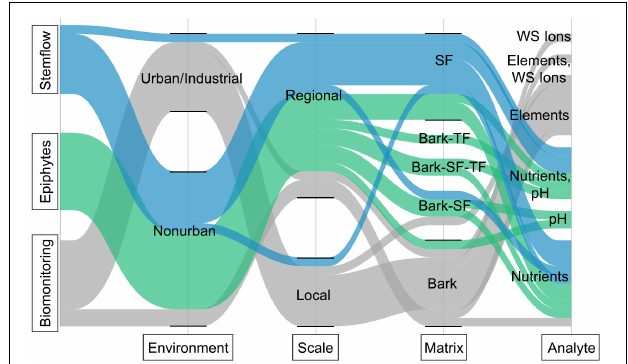
FIGURE 1 | Parallel plot illustrating approaches to the study of bark in three research areas: bark and biomonitoring ( n = 10 studies), bark and stemflow ( n = 8 studies), and bark and epiphytes ( n = 9 studies). The y -axis depicts the three research areas. The width of the parallel lines represents the frequency of studies falling in each category along the x -axis. The x -axis categories include the environment in which the study was conducted (urban/industrial or nonurban), the spatial scale at which the study was conducted (local or regional), the environmental matrix sampled [bark, stemflow (SF), and throughfall (TF)], and the dissolved or particulate analytes. Analytes include water-soluble ions (ws ions), trace and major elements (elements), dissolved and soluble nutrients (nutrients), and